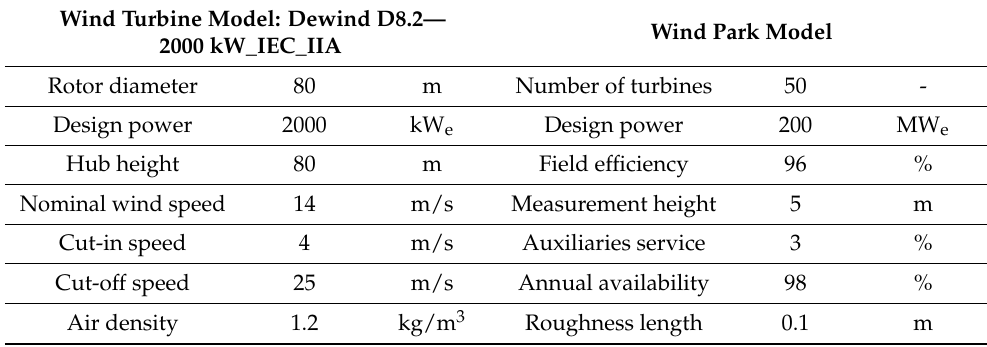
Table 2. Technical details of the technology employed for the “base” wind turbine system [17]. Wind Turbine Model: Dewind D8.2—